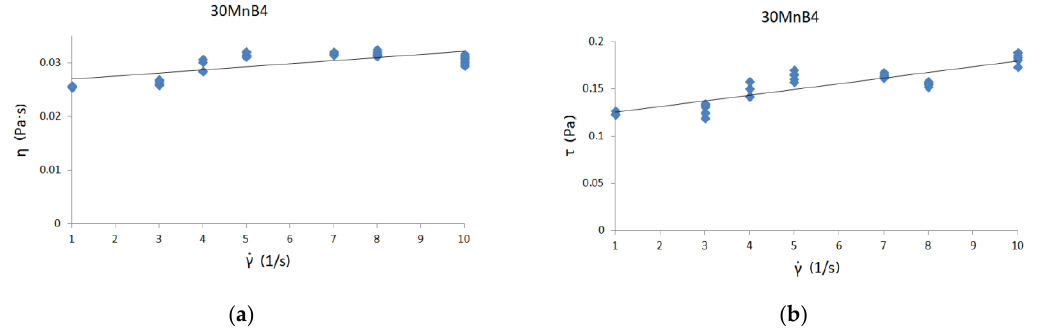
Figure 6. ( a ) Viscosity curve for 30MnB4 steel at 1530 °C; ( b ) flow curve for 30MnB4 steel at 1530 °C.